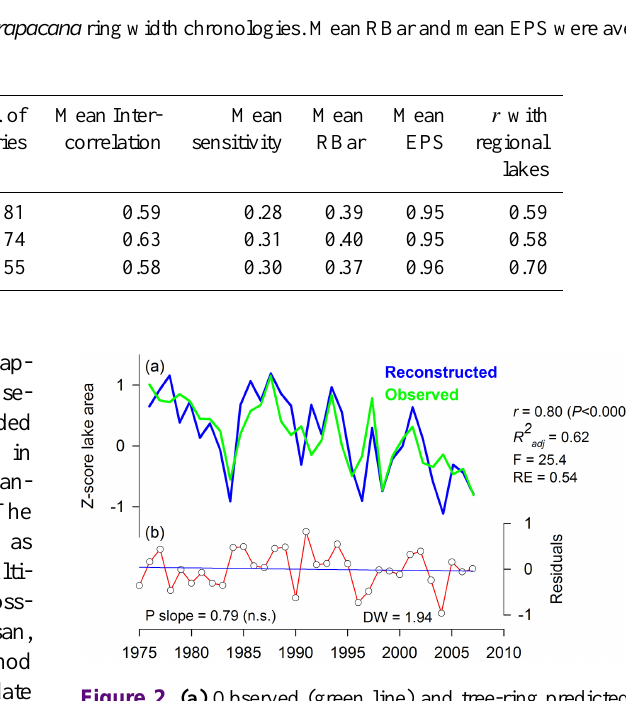
Figure 2. (a) Observed (green line) and tree-ring predicted (blue line) annual lake area (January–December) variations in the NWA- SWB. Annual lake area expressed as a Z score of the satellite- derived 1975–2007 lake area mean. Calibration and verification statistics: the Pearson correlation coefficient ( r ) between observed and reconstructed values, the coefficient of determination adjusted for the degrees of freedom in the model ( R 2 ) over the calibration adj period, the F value of regression (the ratio between the explained and the unexplained variability in the model), and the reduction of error (RE). (b) The linear trend of regression residuals (slope: blue line) and the Durbin-Watson (D-W) statistics used to test for first- order autocorrelation of the regression residuals are